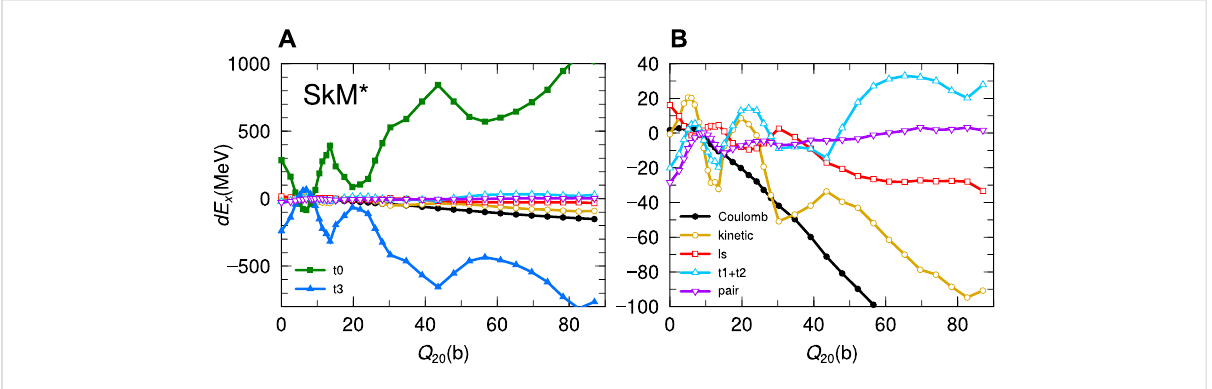
FIGURE 3 (A) Magnitude of the decomposed terms dE x of 236 U along the fi ssion path as in Eq. 4. (B) The same as the left panel but excluding the dE t0 and dE Q t3 terms. They are represented as functions of 20 . The symbols denote the followings: solid squares dE dE dE dE t3 , open circles kin , solid circles Coul , open squares ls , and inverted open triangles